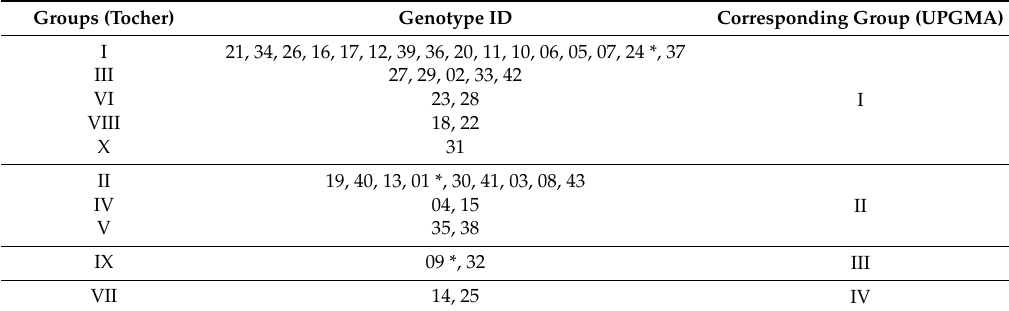
Table 8. Comparison clusters by each clustering method using the Mahalanobis distance (UPGMA and Tocher methods) of 43 genotypes of C. canephora considering four root traits (root length density, root volume, root superficial area, and root volume) and six soil depths (0–10, 10–20, 20–30, 30–40, 40–50, and 50–60